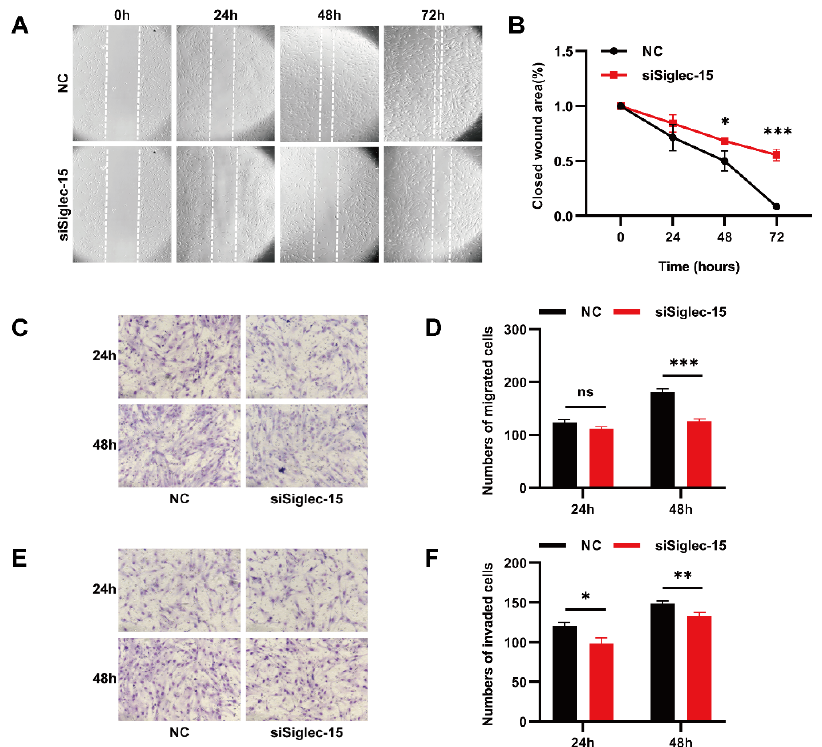
Figure 5. The effect of Siglec ‐ 15 silencing on the migration and invasion of GCTB stromal cells. ( A ) Scratch assay showed the mobility of Hs737. T cells transfected with siSiglec ‐ 15 compared with the NC group. ( B ) The remaining area was obviously wider in the siSiglec ‐ 15 group than in the NC group at 48 h and 72 h. ( C , D ) Transwell migration assays showed decreased migration of Hs737 T cells transfected with siSiglec ‐ 15 at 48 h compared with the NC group. ( E , F ) Transwell invasion assays showed the decreased invasion ability of Hs737. T cells transfected with siSiglec ‐ 15 at 24 h and 48 h compared with the NC group. Scale bars, 200 μ m, * p < 0.05, ** p < 0.01, *** p < 0.001. ns means no significance.